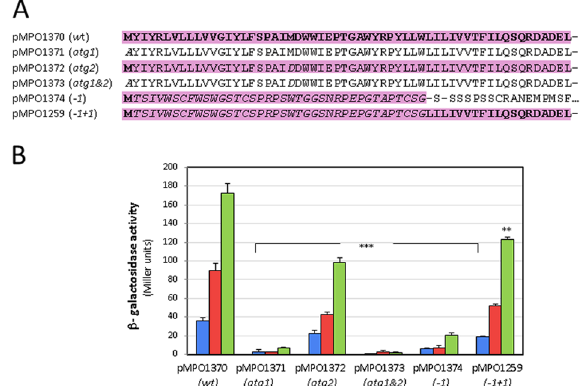
Figure 6. Point mutations in cbrX and their effect on CbrA expression. ( A ) The reading frame of CbrX for the wild type cbrXA sequence (pMPO1370; wt) and point mutations at the putative start ATG (pMPO1371, atg1), at an ATG codon downstream (pMPO1372; atg2), both ATG codons mutated (pMPO1373; atg1&2), a T deletion at coordinate + 4 from the ATG of cbrX (pMPO1374; -1) and a T deletion and subsequent reversion of the reading frame with a C insertion at + 118 from the ATG (pMPO1259; -1, + 1) are represented. Residues corresponding to CbrX in its wild type reading frame are shown in bold, the predicted amino acid sequences of translated peptides are shaded in pink. Amino acids in italic are residues not coincident with the wild type CbrX sequence. ( B ) Quantification of cbrA expression by β -galactosidase activity of translational cbrA ’-‘ lacZ fusions carrying wild type sequence (pMPO1370) and point mutations in cbrX sequence in pMPO1371, pMPO1372, pMPO1373, pMPO1374, pMPO1259. β -galactosidase activity was monitored in P. putida KT2442 in LB (blue) and M9 medium supplemented with succinate (red) or oxalacetate (green). Bars represent the averages and standard deviations of at least three independent assays. Stars designate p-values for the Student’s t-test for unpaired samples not assuming equal variance. * p < 0.05; ** p < 0.01; *** p <